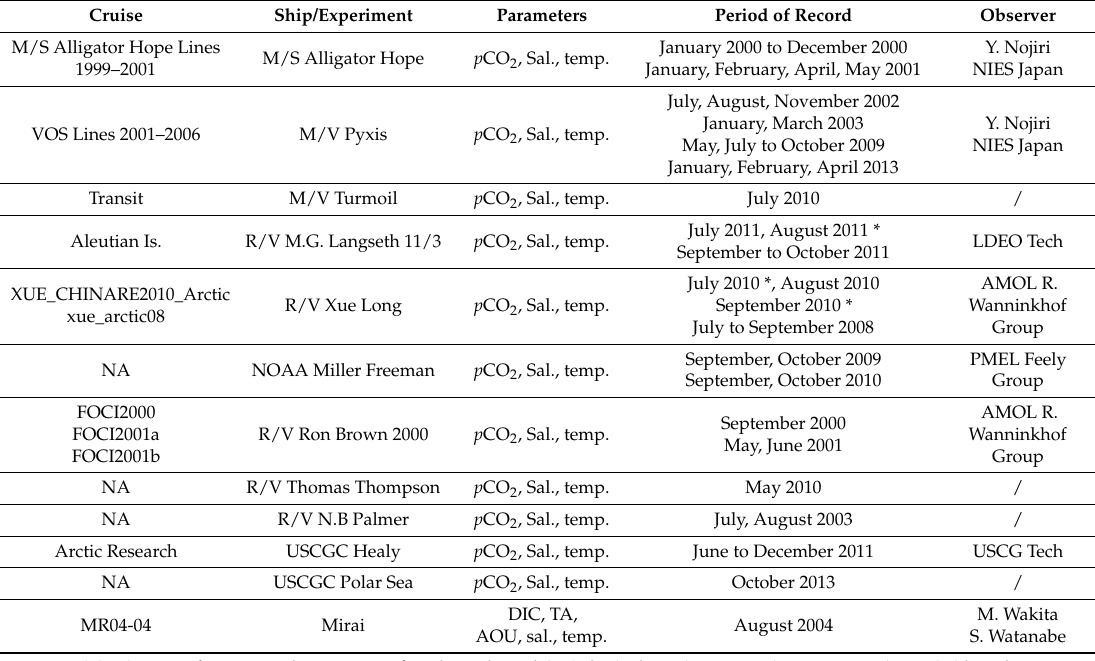
Table 1. Basic information for underway data and discrete carbonate data from CDIAC used in this